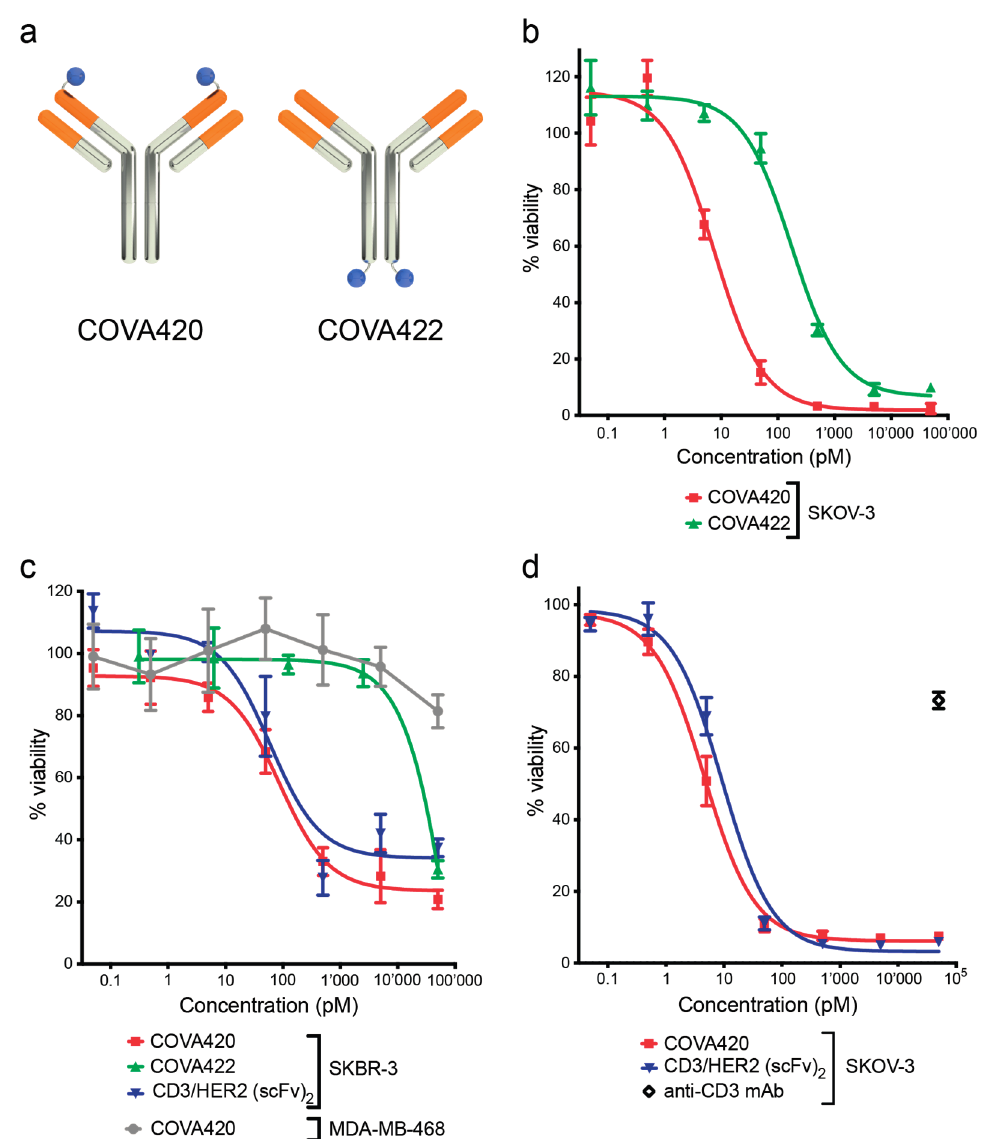
Figure 1. ( a ) Graphic representation of CD3/HER2 FynomAb architectures used in this study. COVA420: N-terminal heavy chain fusion; COVA422 C-terminal heavy chain fusion. ( b – d ) Redirected T cell cytotoxicity assay on different HER2 positive or HER2 negative cell lines. Target cells were co-cultured with effector cells in the presence of FynomAbs or control molecules. Cytotoxicity was assessed in a colorimetric XTT assay. Data were normalized as described in the experimental section and are shown as mean % viability ± SD. Panel b shows COVA420 (red) and COVA422 (green) on HER2 positive SKOV-3 cells. Panel c shows COVA420, COVA422 and CD3/HER2 (scFv) 2 (blue) on SKBR-3. EC 50 values were 60 pM (CD3/HER2 (scFv) 2 ); 87 pM (COVA420) and >10 nM (COVA422). No cytotoxicity was induced by COVA420 on HER2 negative MDA-MB-468 cells (grey). Panel d shows a comparison between COVA420 and CD3/HER2 (scFv) 2 on SKOV-3 cells with EC 50 values of 9.3 pM for COVA420 and 4.6 pM for the CD3/HER2 (scFv) 2